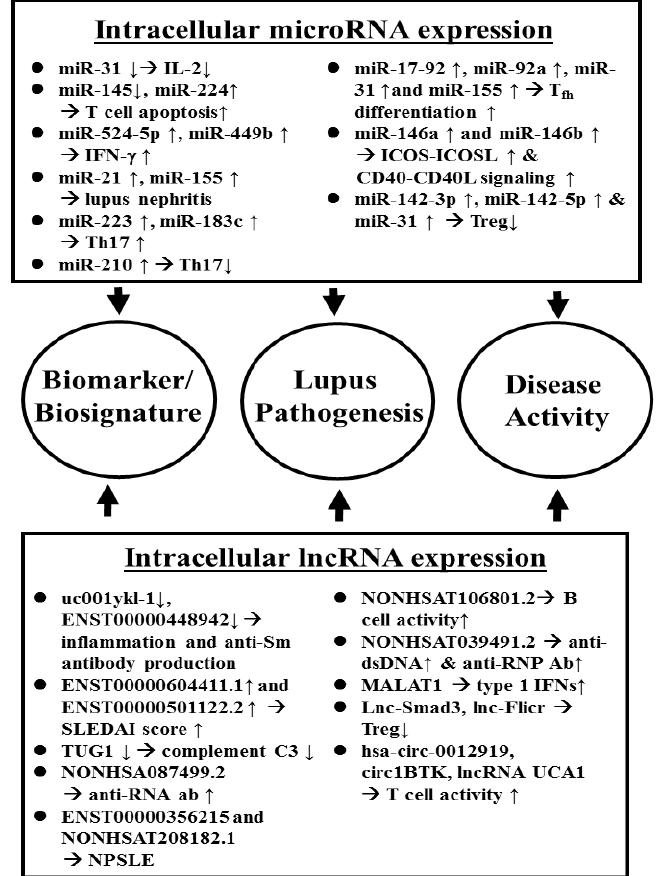
Figure 1. Aberrant intracellular ncRNA expression in the pathogenesis, and as disease biomarkers / biosignatures as well as disease activity index of SLE.